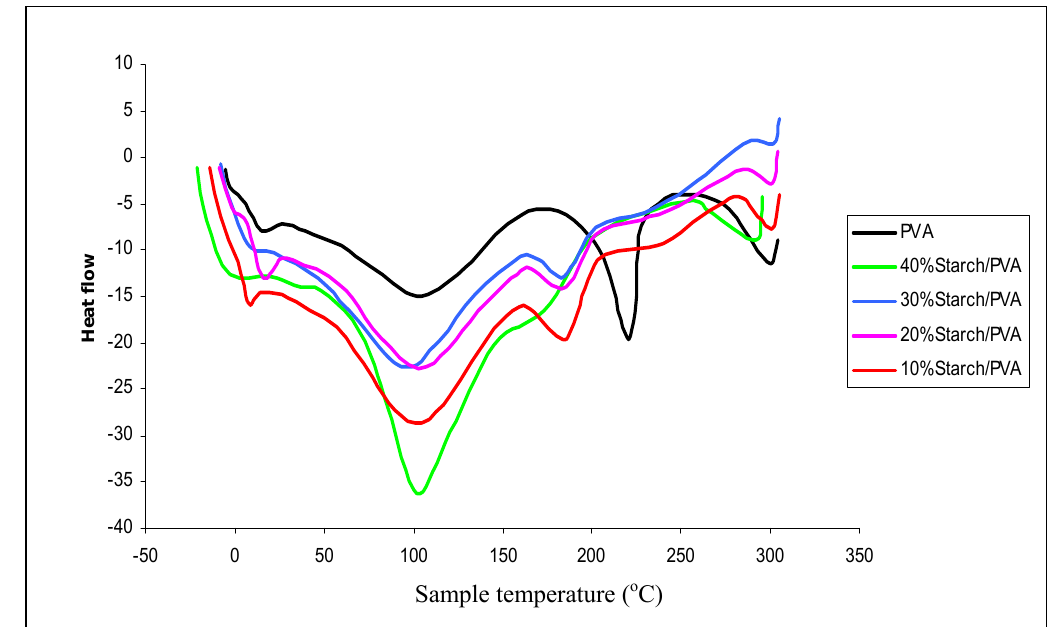
Fig. 3: DSC analysis of PVA, and Starch/PVA at different